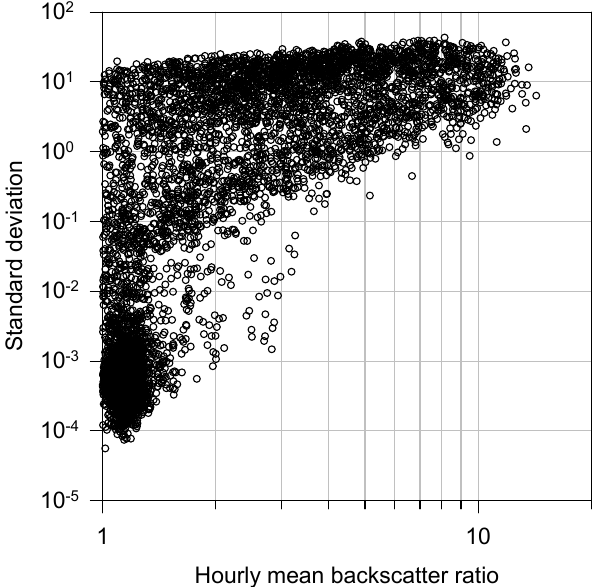
Fig. 8. Relation between the hourly mean aerosol backscatter ra- tio and standard deviation at 500m above ground level over Syowa Station, Antarctica in 2012.